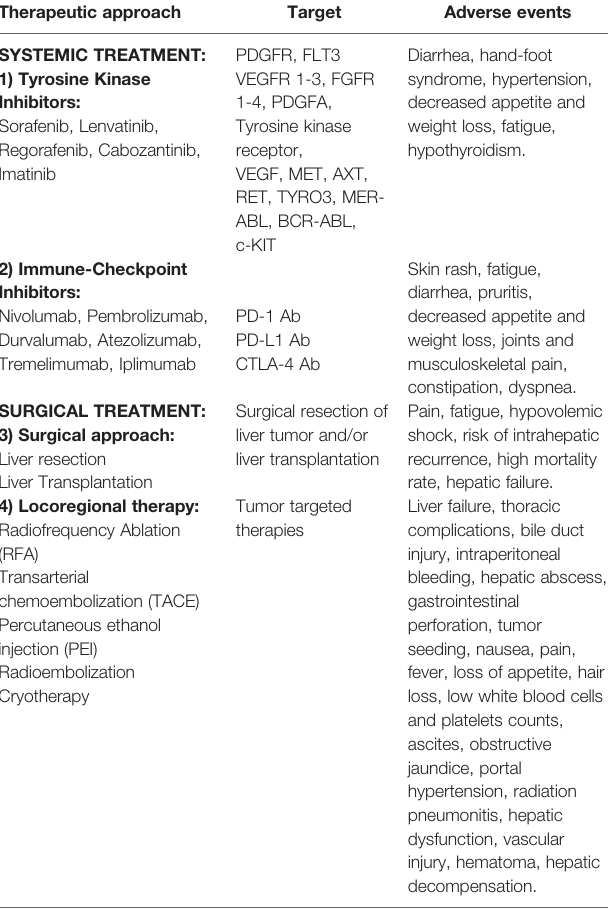
TABLE 1 | Adverse events associated with systemic and surgical hepatocellular carcinoma (HCC) treatment approaches. Therapeutic approach